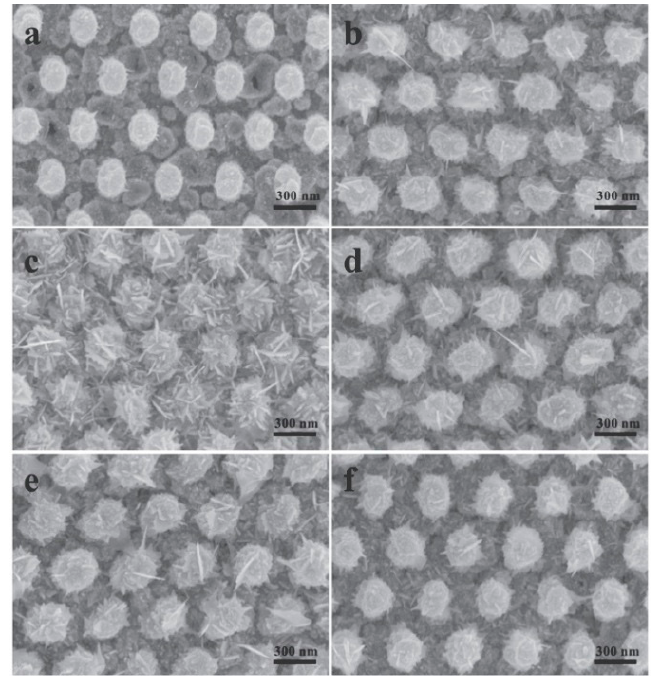
Figure 32. SEM images of the gold nanochestnuts grown at the top of the nanopillars by galvanic displacement at different reaction times: 10 min ( a ), 15 min ( b ), 20 min ( c ), 30 min ( d ), 45 min ( e ), and 65 min ( f ). Reproduced with permission from Geng et al. [351]. Copyright (2018), IOP Publishing Ltd.